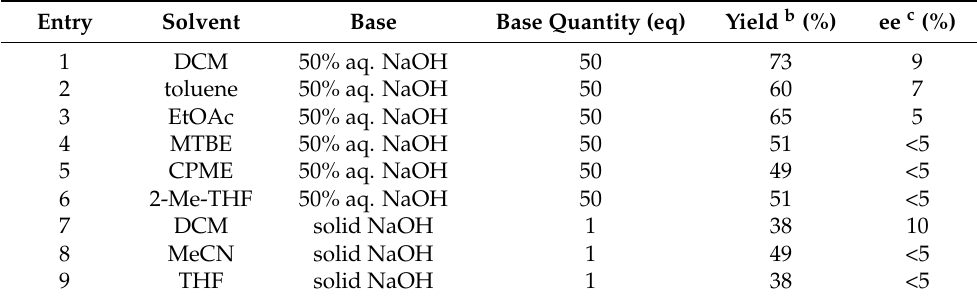
Table 2. Examination of the effect of the solvent in the presence of catalyst C5 a